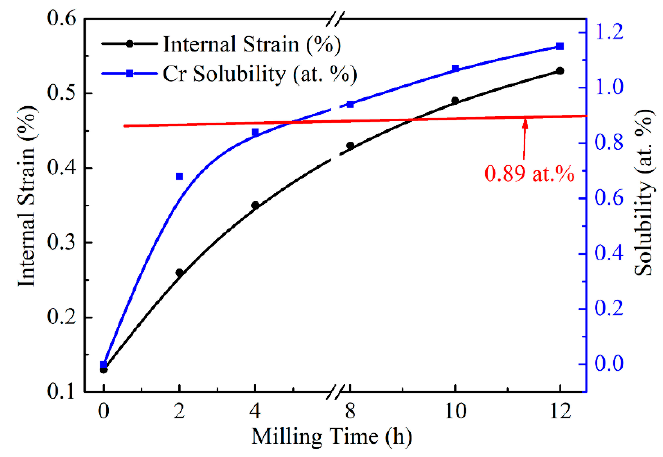
Figure 6. Effect of milling time on Cu internal strain and Cr solid solubility. Figure 6. E ff ect of milling time on Cu internal strain and Cr solid